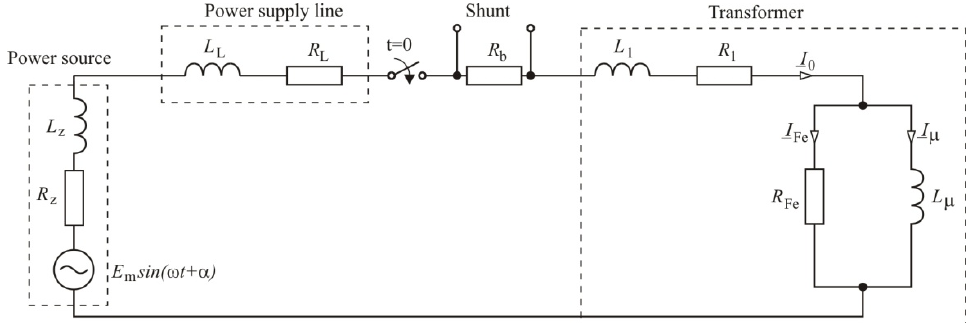
Figure 12. Measuring system.